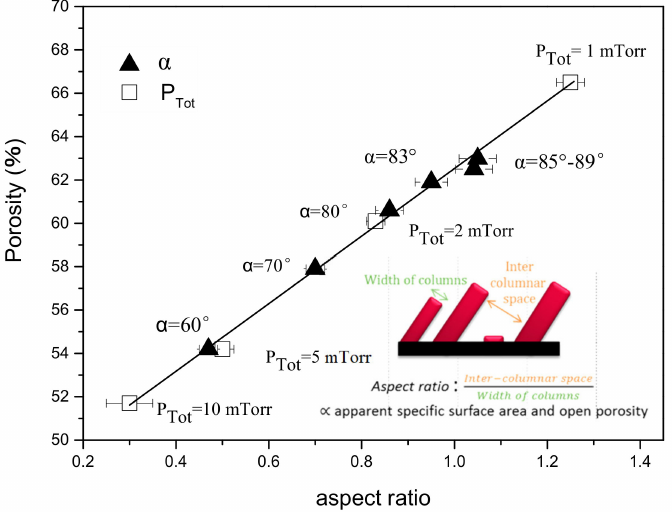
Figure 11. Evolution of the porosity as a function of the aspect ratio for Mg nano-sculpted films deposited at various deposition pressures and α . The inset illustrates the definition of the aspect ratio, Г (adapted from [32], MDPI,